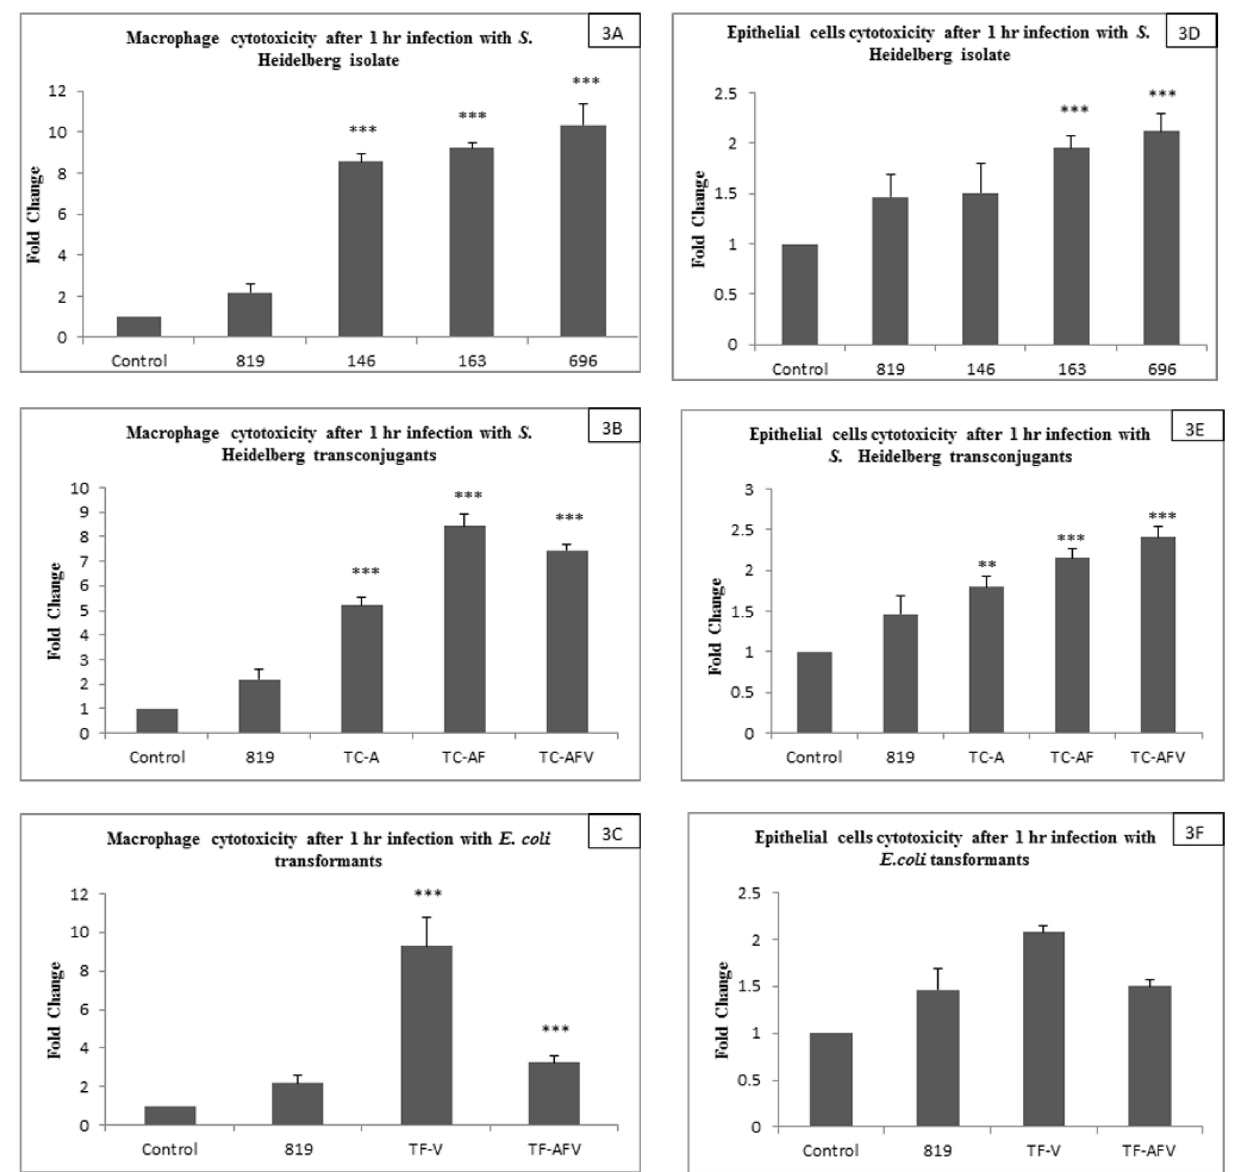
Figure 3. In vitro model to assess cytotoxocity in macrophages and epithelial cells following 1 hr infection with S. Heidelberg strains (146, 163, 696), transconjugates and transformants that harbor transmissible plasmids and T4SS and strain that lacks both (819 and E. coli One Shot TOP10). Panels A-C shows the cytotoxic effect (as determined by cytosolic LDH levels) in macrophages infected with S. Heidelberg isolates, transconjugants and transformants, while panels D-F shows the cytotoxic effects in epithelial cells infected with these strains. The results are expressed in fold changes as compared control among different isolates with and without mobile plasmids. Each data point represents the means and standard deviation for 5 individual